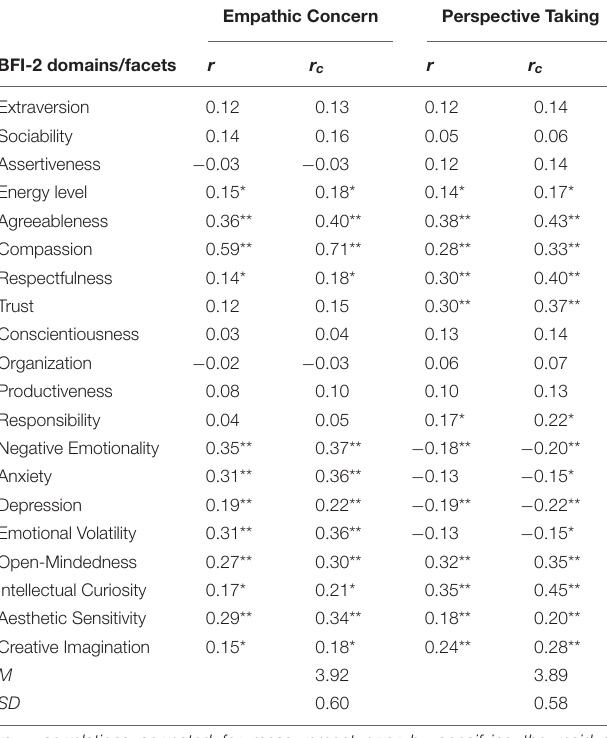
TABLE 6 | Self-ratings of BFI-2 and correlations with empathic concern and perspective taking. Empathic